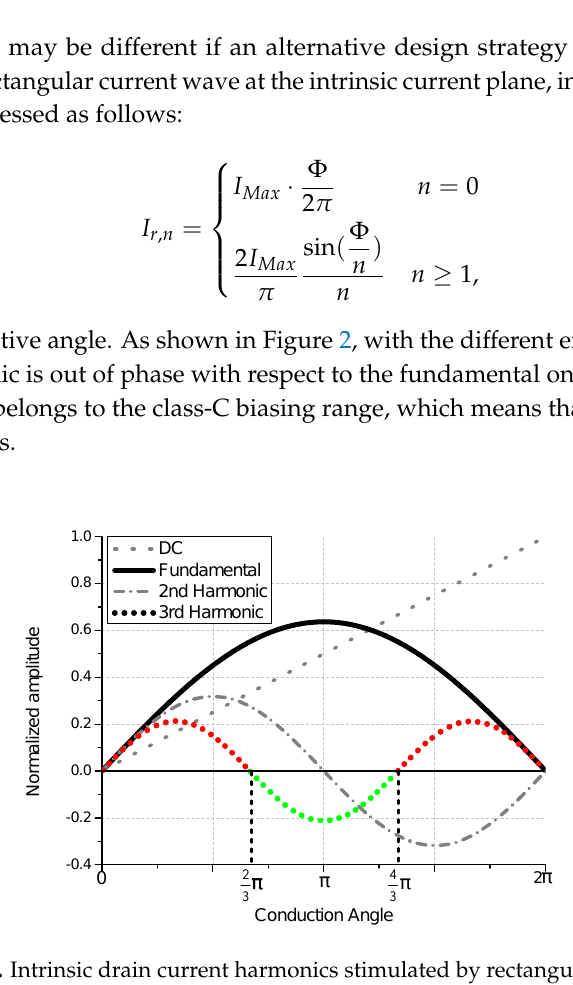
Figure 2. Intrinsic drain current harmonics stimulated by rectangular